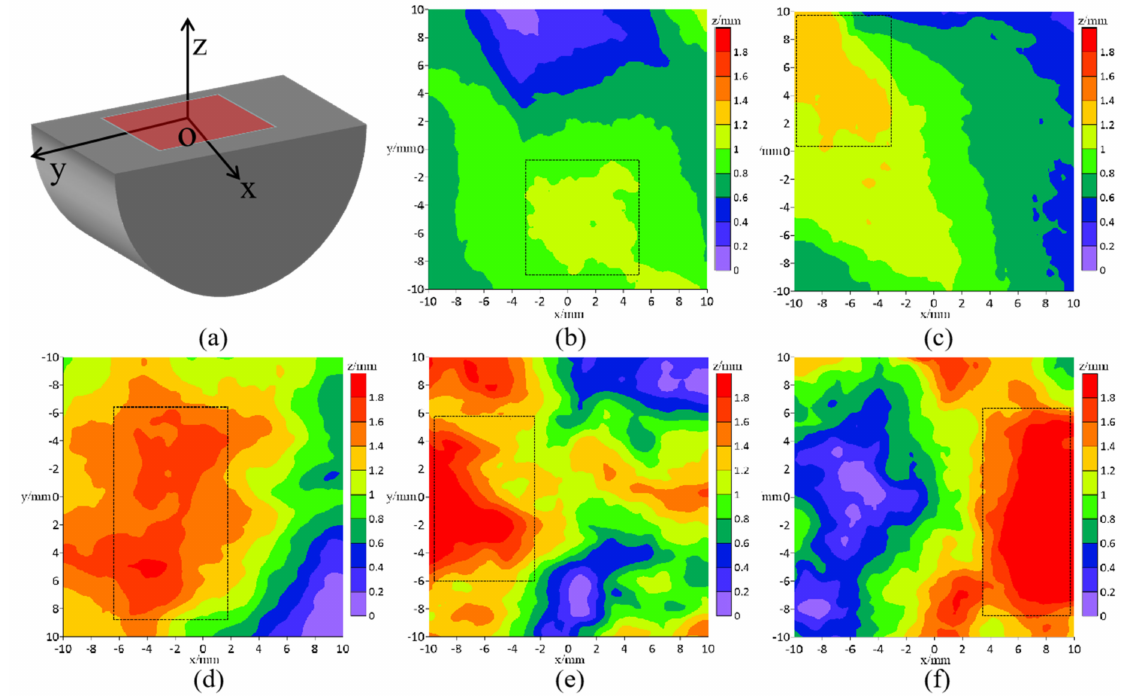
Figure 10. Point cloud of relative elevation of splitting fracture surface under different temperatures and pressures: ( a ) space rectangular coordinate system ( b ) 25 ◦ C—0 MPa, ( c ) 50 ◦ C—10 MPa, ( d ) 80 ◦ C—20 MPa, ( e ) 110 ◦ C—30 MPa, and ( f ) 140 ◦ C—40 MPa. At the test temperatures and pressures of 25 ◦ C—0 MPa, 50 ◦ C—10 MPa, 80 ◦ C—20 MPa, 110 ◦ C—30 MPa, and 140 ◦ C—40 MPa, the roughness values of the specimens are